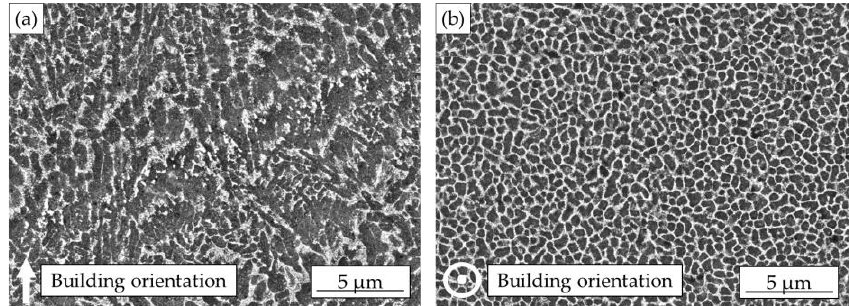
Figure 3. Columnar and cellular substructure of α-aluminum (dark) and eutectic phase (bright) for